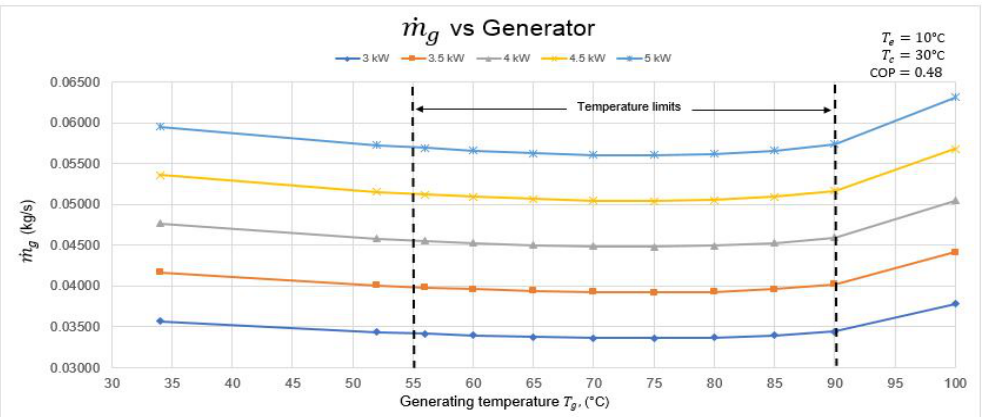
Figure 9. Mass flow of the generator ( ˙ m g ) considering five powers